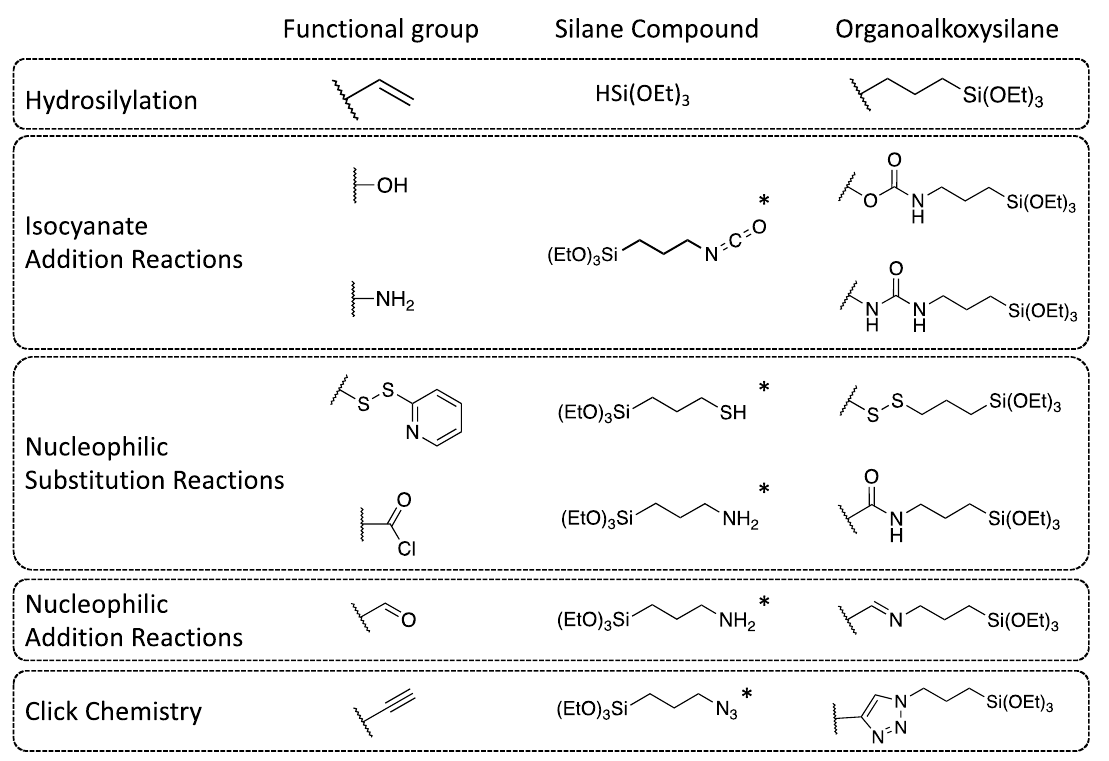
Figure 3. Types of functional groups and possible synthetic strategies to obtain organoalkoxysilanes. * Indicates commercially available organoalkoxysilanes precursors.